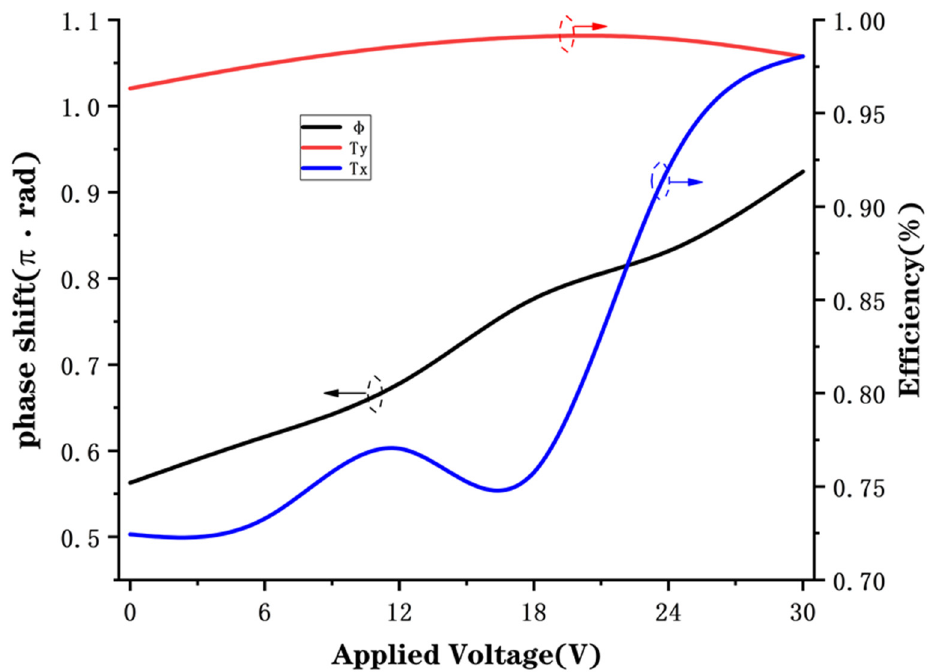
Figure 4. Simulated transmission of the metasurface and phase shift of emergent light as a function of applied voltage when the linearly polarized light normal incident to the metasurface. The black line represents the phase shift, the red line represents the transmission efficiency T x, and the blue line represents the transmission efficiency T y.